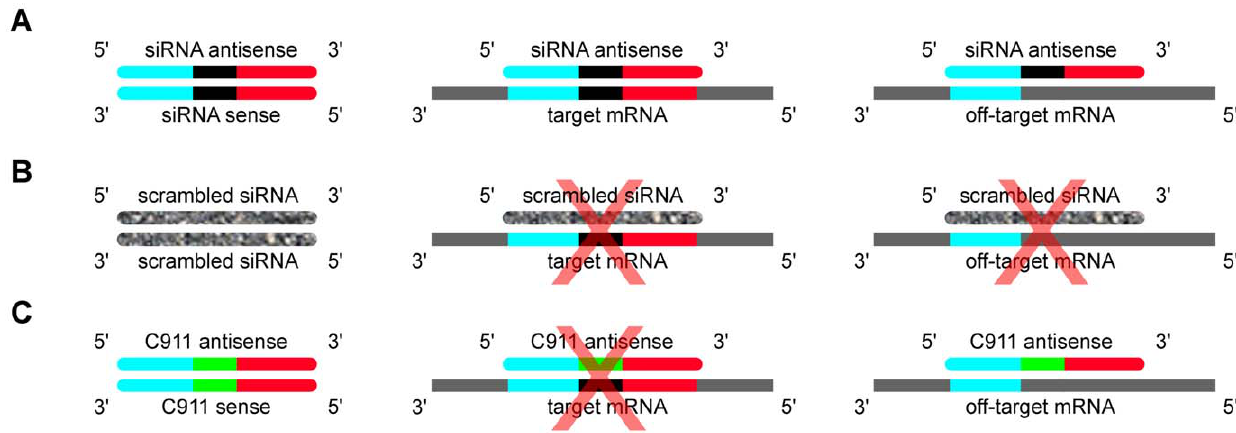
Figure 1. On and off-target effects of siRNAs and their controls. An siRNA ( A, left panel ) consisting of two complementary 19-mers of RNA (with two-base overhangs) is divided here conceptually into the 5 9 end of the anti-sense strand (teal) the middle of the siRNA (black) and the 3 9 end of the anti-sense strand (red). siRNAs are designed to be the reverse-completment of the mRNA sequence they are targeted to down-regulate ( A , middle panel ), but matches of the seed sequence of an siRNA to the 3 9 UTR of other mRNAs can result in their off-target down-regulation as well ( A , right panel ). A scrambled siRNA ( B ) eliminates the match to the target mRNA and thus will not down-regulate it, but also eliminates the off-target effects due to matches to the seed sequence (while, perhaps, creating new off-target effects against the new seed sequence). The C911 mismatch control ( C ) reduces or eliminates the down-regulation of the targeted mRNA by taking the complement of the middle three bases (green), but maintains the off-target effects of the original siRNA by keeping anti-sense and sense strand seed sequences intact. In this manner, comparison of effects elicited by the original siRNA and the C911 mismatch control should allow us to distinguish phenotypes that are due to down-regulation of the intended target rather than off-target effects.